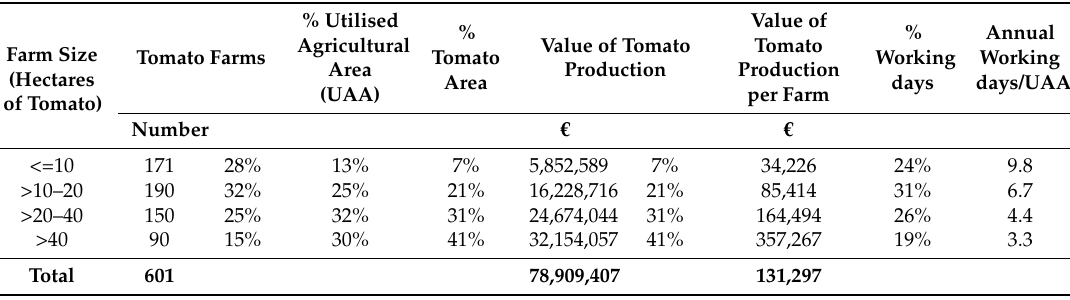
Table 1. Tomato farms in the study area.